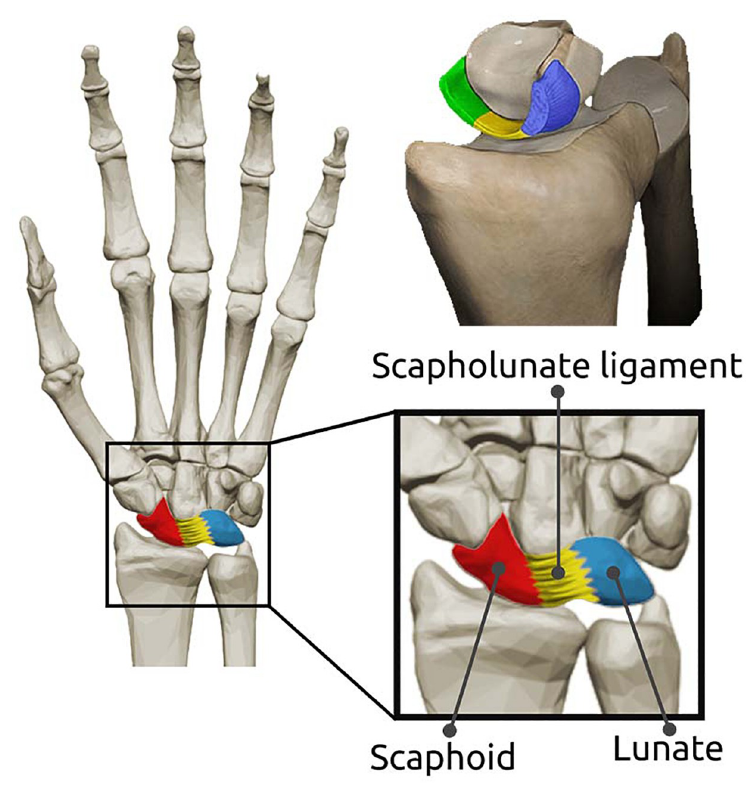
Fig 1. Wrist anatomy. Within the carpal bones of the wrist are the scaphoid and lunate bones. The scaphoid and lunate are held together by a the interosseous scapholunate ligament. A three-dimensional rendering of the scapholunate interosseous ligament is presented (top right). Removing the scaphoid reveals the dorsal (blue), proximal (yellow), and volar (green) regions of the the interosseous scapholunate